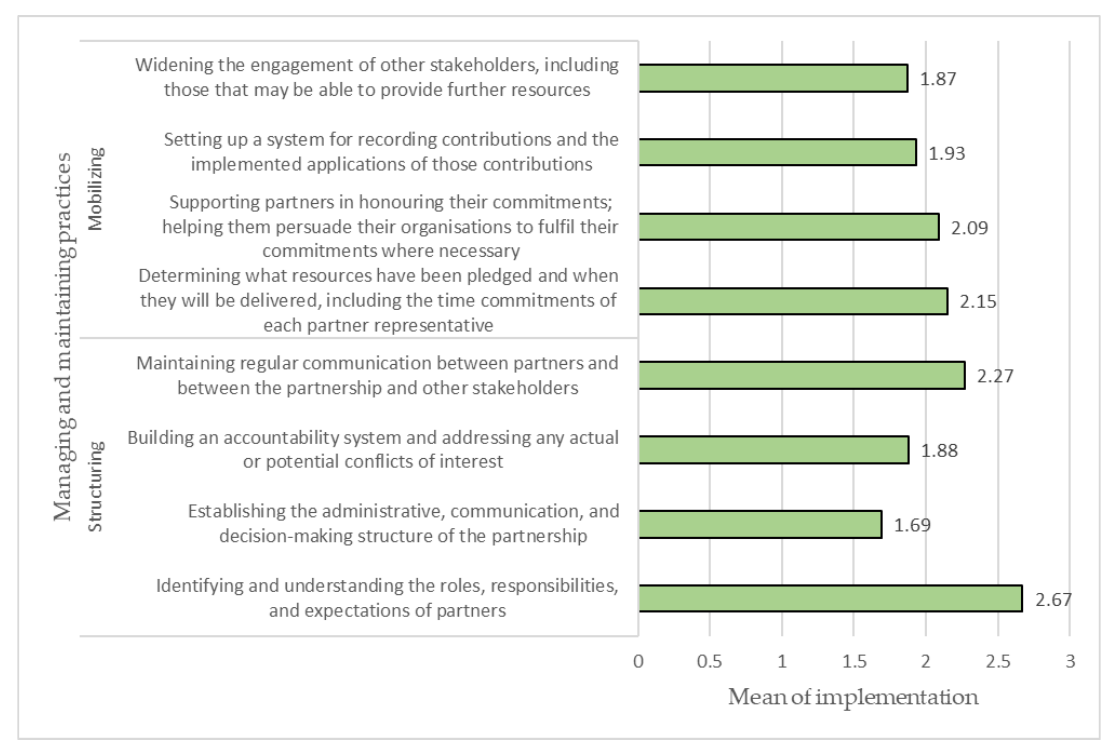
Figure 4. Managing and maintaining practices applied in the partnerships.